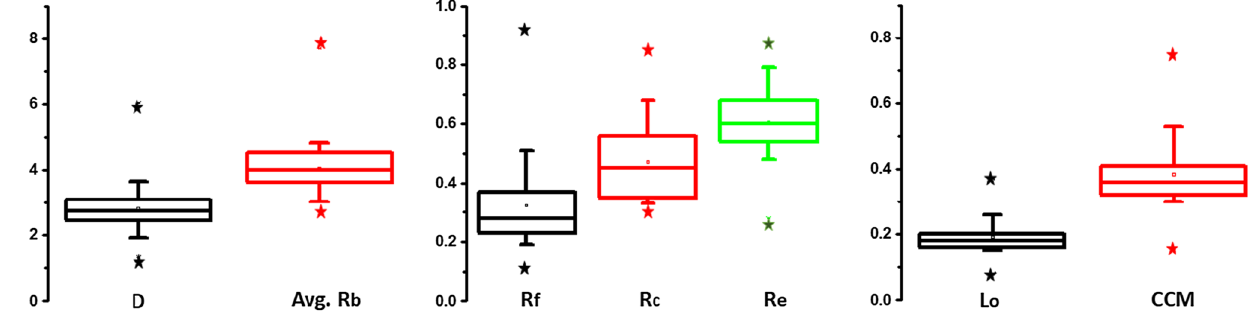
Fig. 3 Box whisker plots for drainage density ( D ), average bifurcation ratio ( R length of overland flow ( L o ) and constant channel maintenance